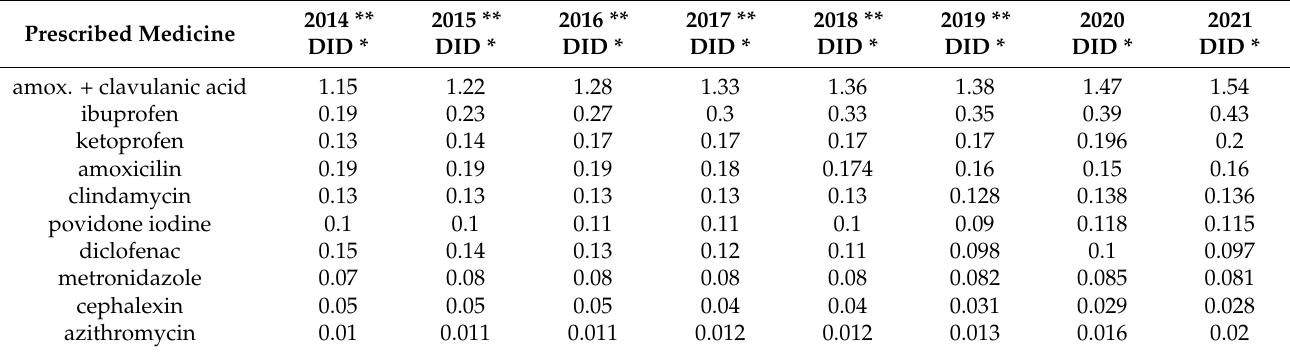
Table 2. The 10 most frequently prescribed medications in DID for period 2014–2021.